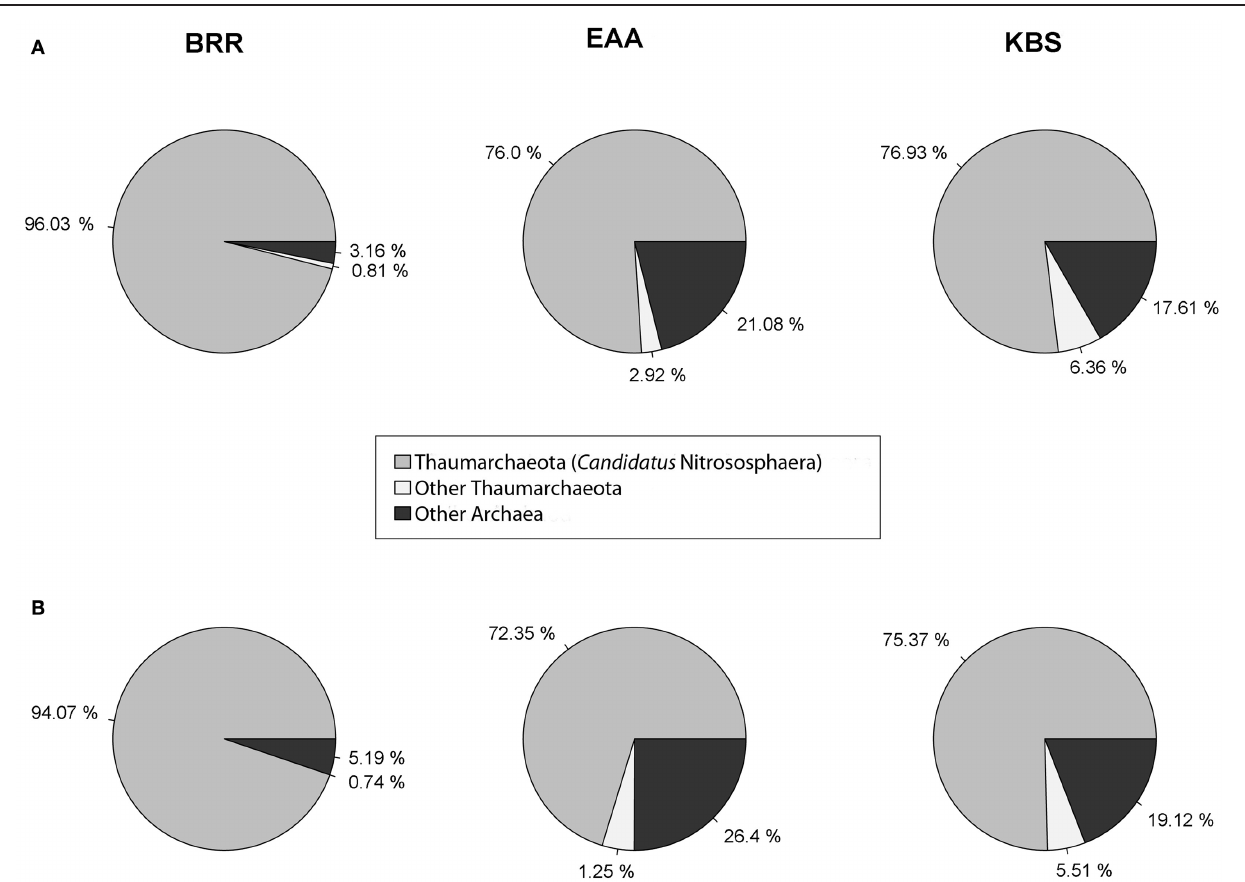
FIGURE 4 | Representation of total Archaea domain found in agricultural plots (A) and in non-agricultural plots (B) at the Broadbalk Experiment at Rothamsted Research (BRR), the Everglades Agricultural Area (EAA) and the Kellogg Biological Station